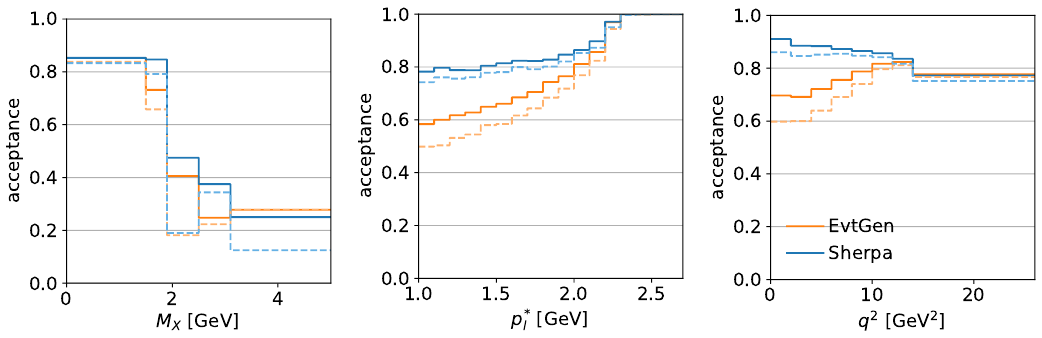
Figure 7 . Signal acceptance as a function of M X , p ∗ NN (dashed lines) defined in eq. binned